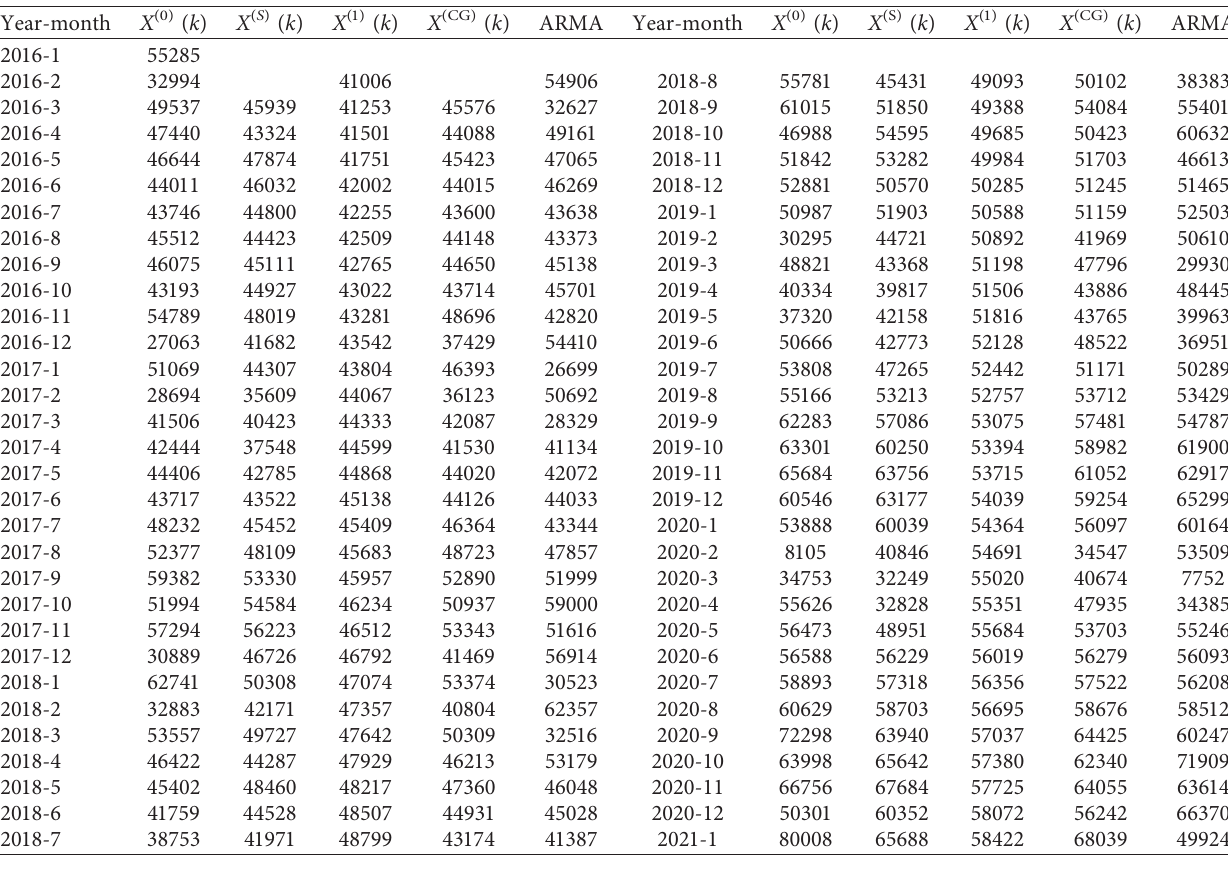
Table 3: Grey transformation data of Audi car